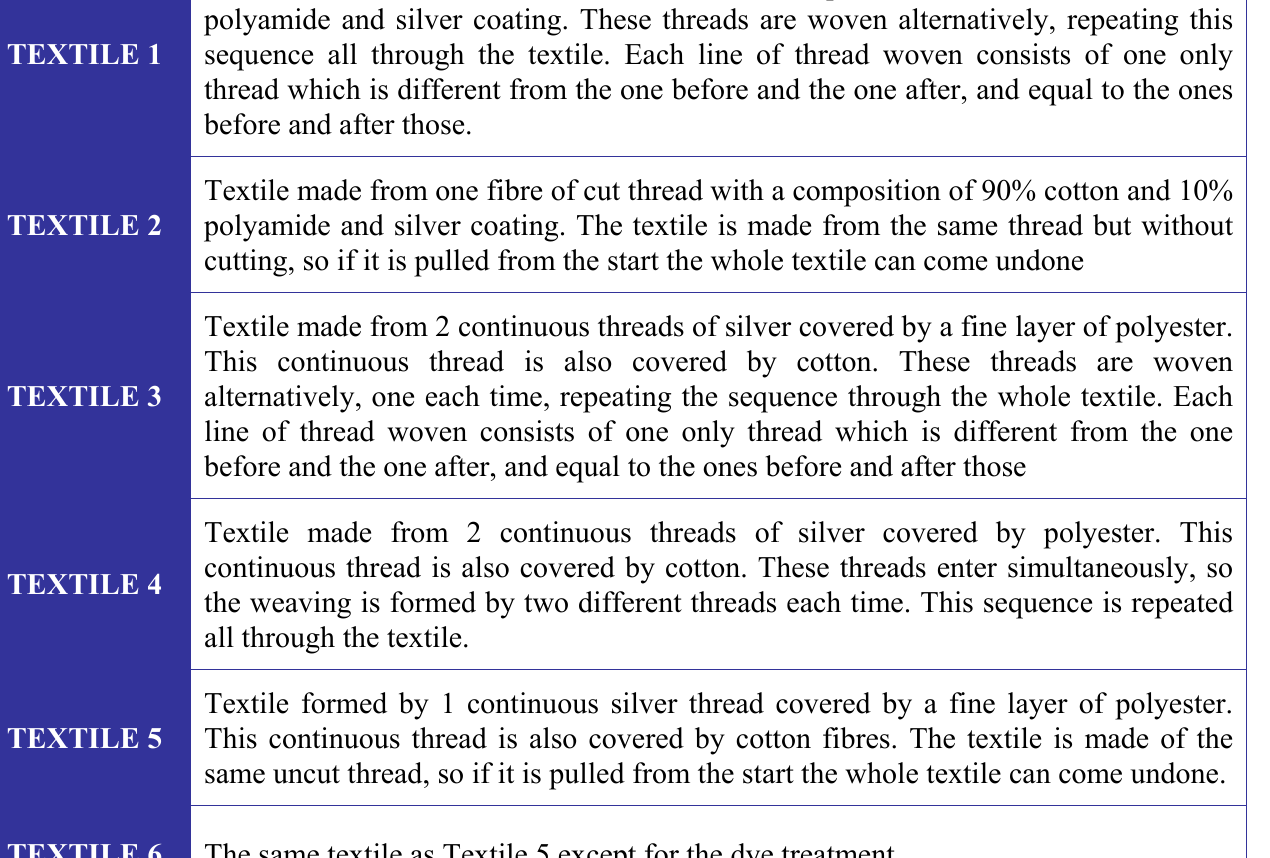
Table 1. Specifications of the